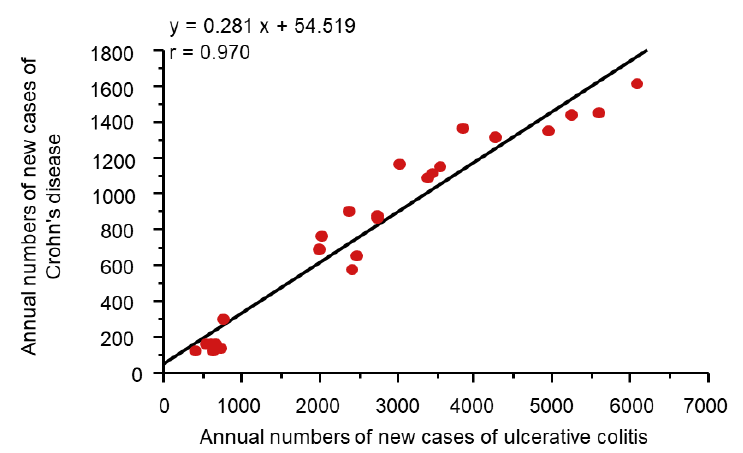
Figure 4. Chronological change in dietary intake and incidence of inflammatory bowel disease in Japan. The daily intake per capita of rice, animal protein, and animal fat is shown in the upper panel based on data for 35 years from 1965 to 2000 collected in the National Nutritional Survey. The inci- dence of ulcerative colitis and Crohn ’ s disease every 5 years is shown in the lower panel.